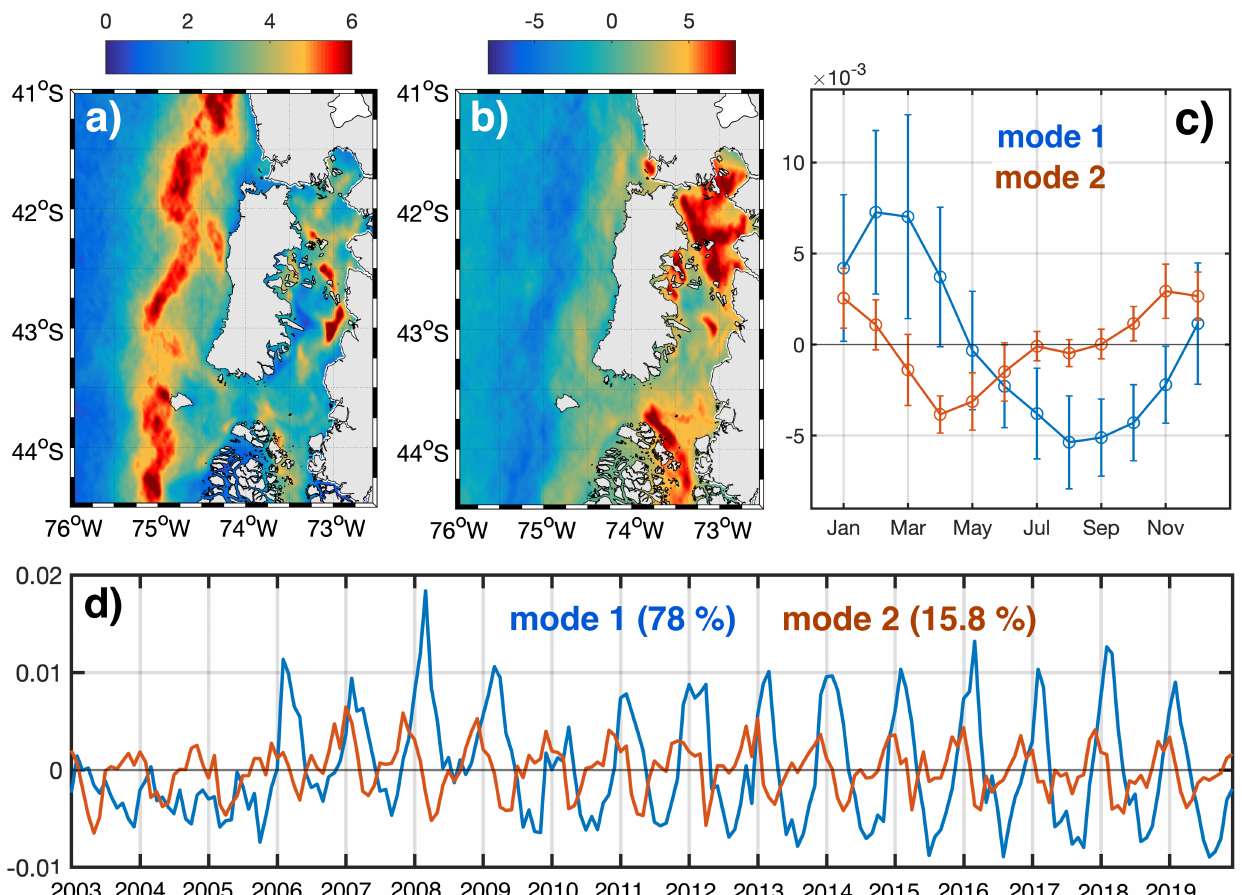
Figure 5. EOF analysis of SST gradient magnitudes. ( a ) First and ( b ) second EOF modes. ( c ) Mean annual cycle of EOF time series shown in ( d ). The error bars in ( c ) correspond to the monthly standard